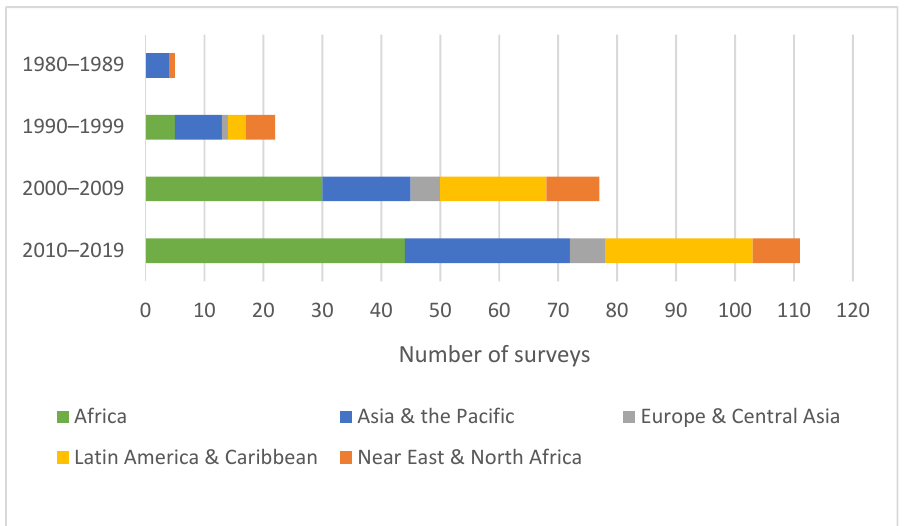
Figure 4. Number of dietary surveys conducted in LMICs during 1980–2019 by decade and geo- graphical region, excluding longitudinal surveys. Data shown reflect the situation as of May 2022. Geographic regions are defined according to the FAO operational classification. Only LMICs are included for all regions, including Europe and Central Asia.